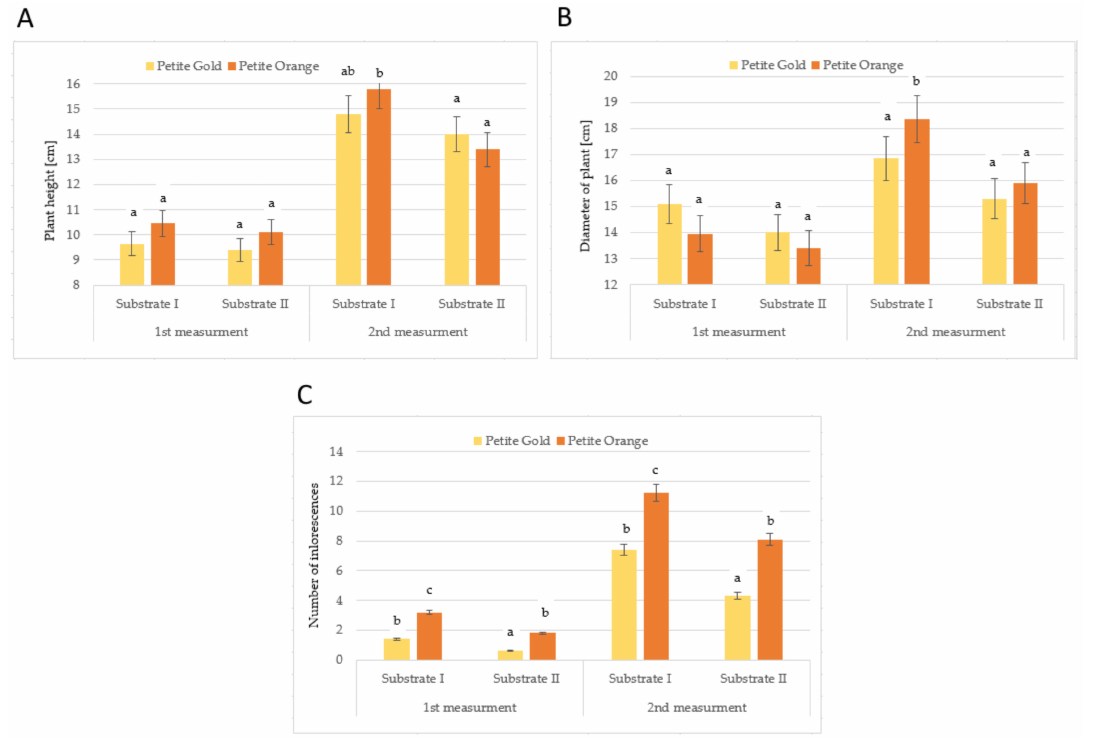
Figure 1. Plant height ( A ), diameter of plants ( B ) and number of inflorescences ( C ) of Tagetes ‘Petite Gold’ and ‘Petite Orange’ depending on the substrate used (after exposure to W light). Means followed by the same letters are not significantly different.